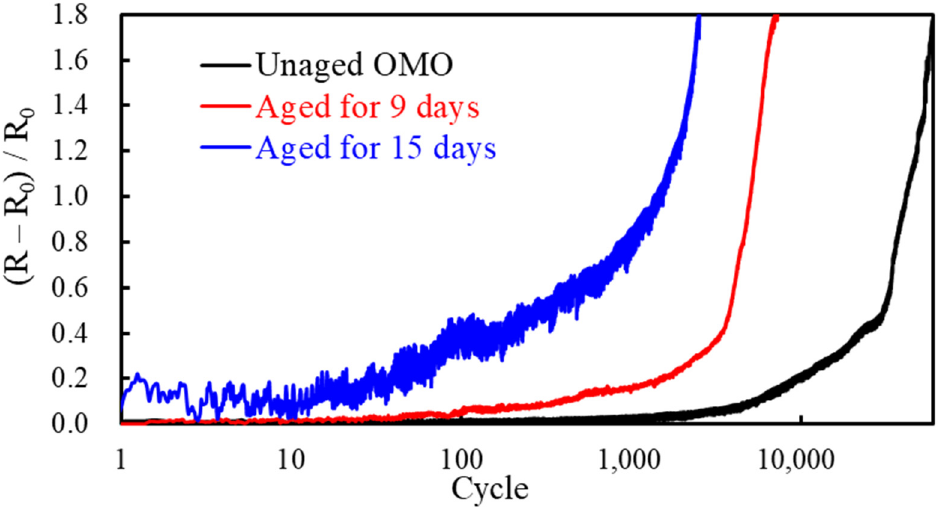
Figure 8. Real-time recording results of the increase in normalized resistance as a function of cyclic bending cycles for OMO samples with and without accelerated weathering tests.